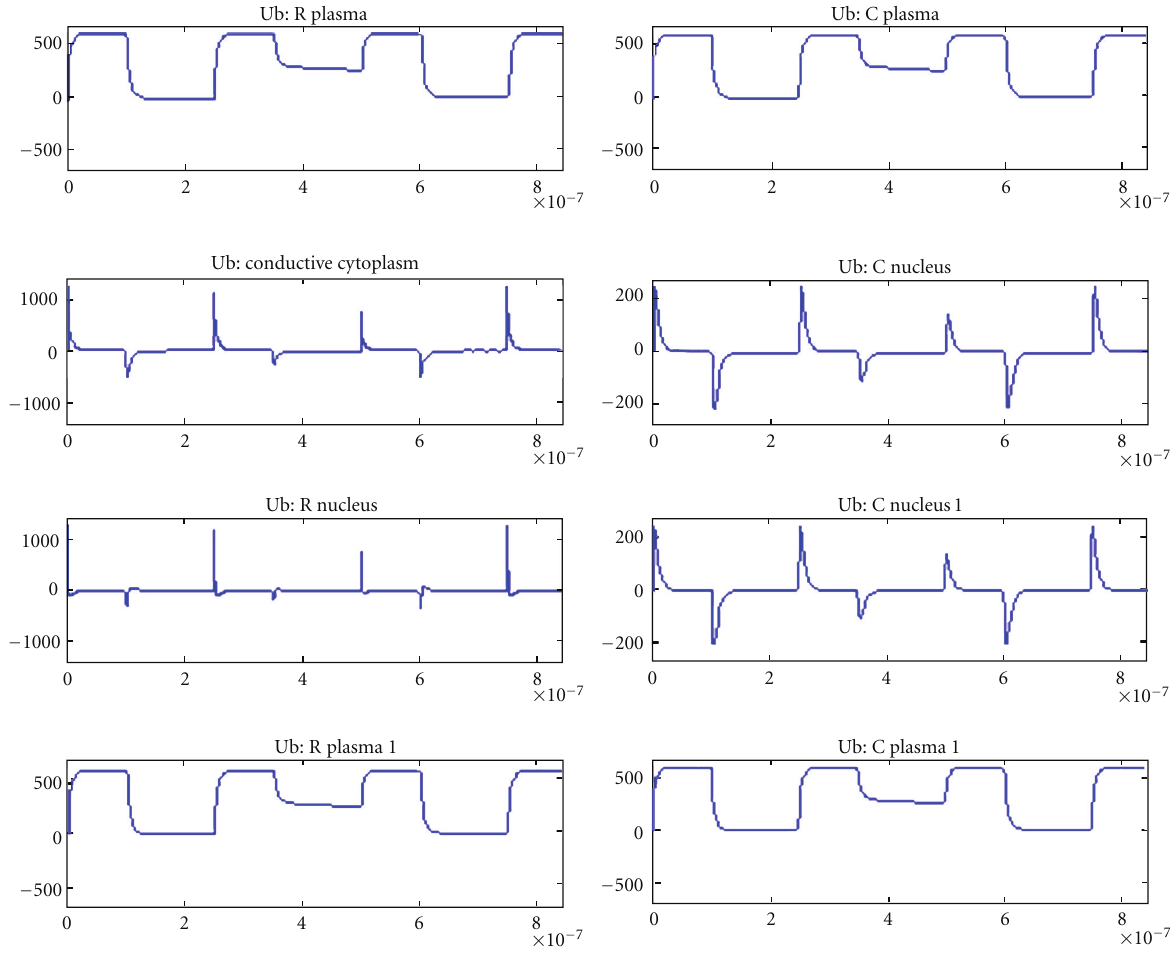
Figure 8: Voltage across various cell elements in tissue with two tumor